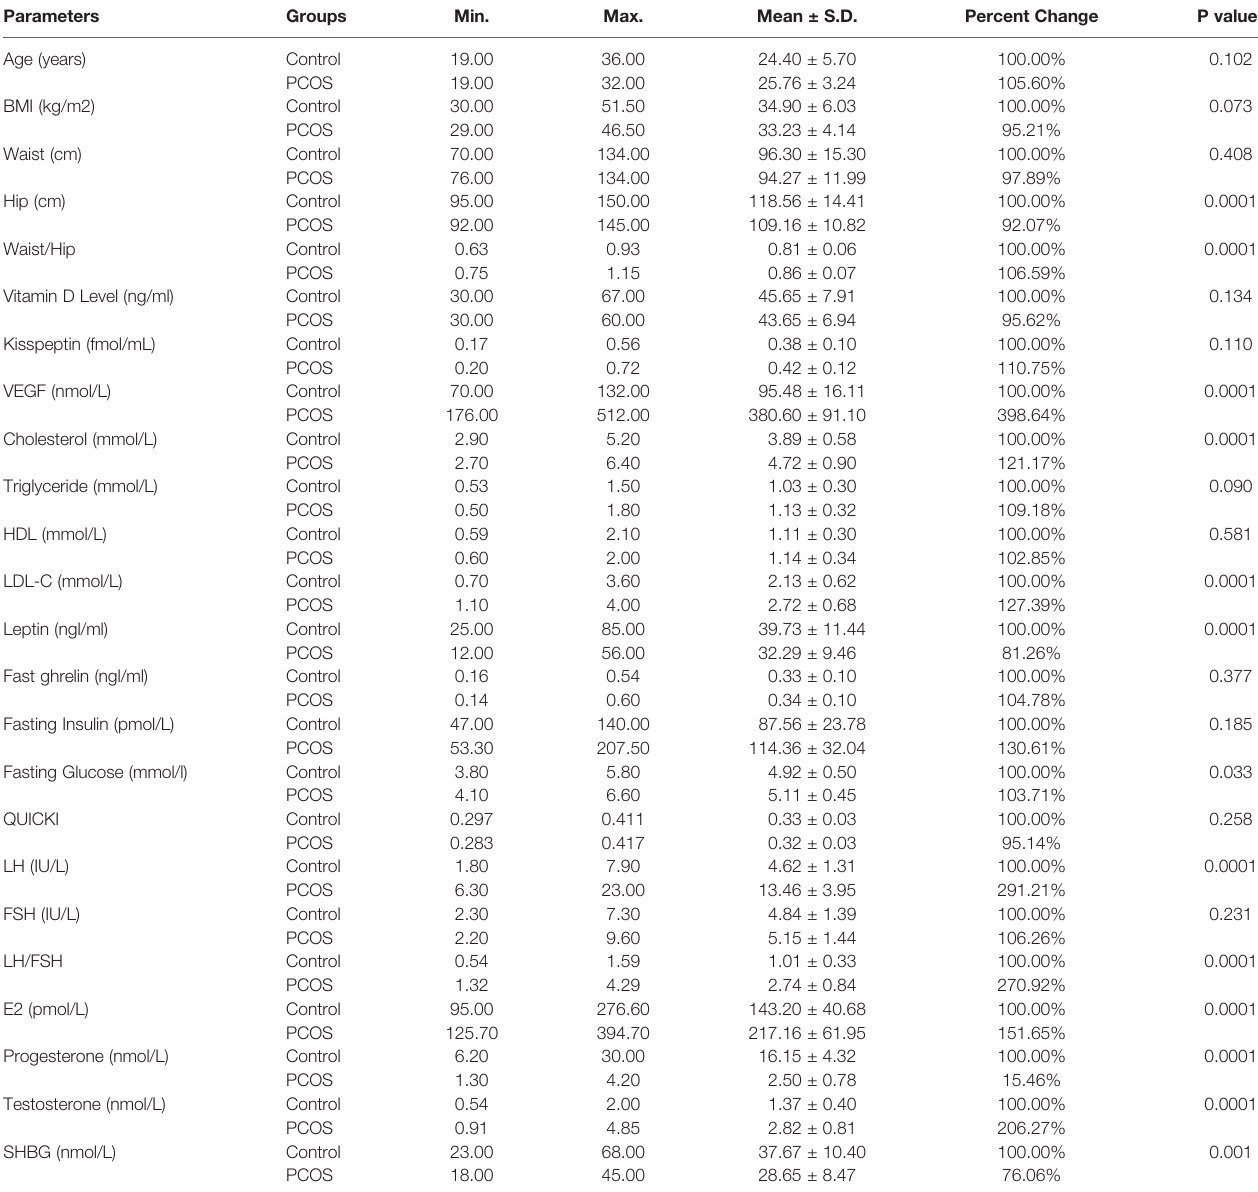
TABLE 1 | The mean, SD, percentage change minimum and maximum values for the studied parameters in obese PCOS and obese controls, and the signi fi cance of the difference between the two groups. Parameters Groups Min. Max. Mean ± S.D. Percent Change P